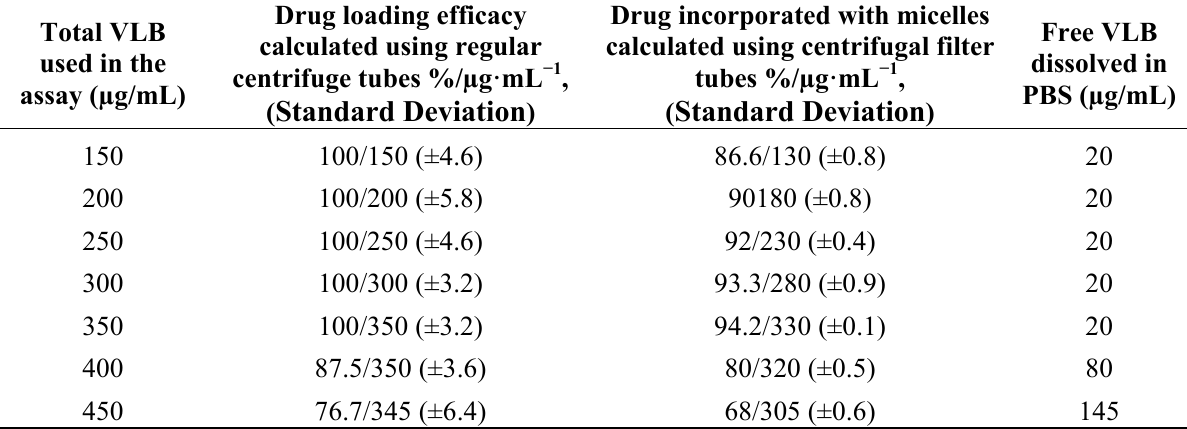
Table 4. Maximum solubility and the incorporation percentage of VLB in 5 mg of micelles made of Y-shaped block